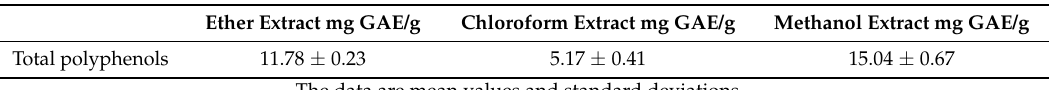
Table 3. Content of polyphenols in their extracts of Pereskia aculeata.